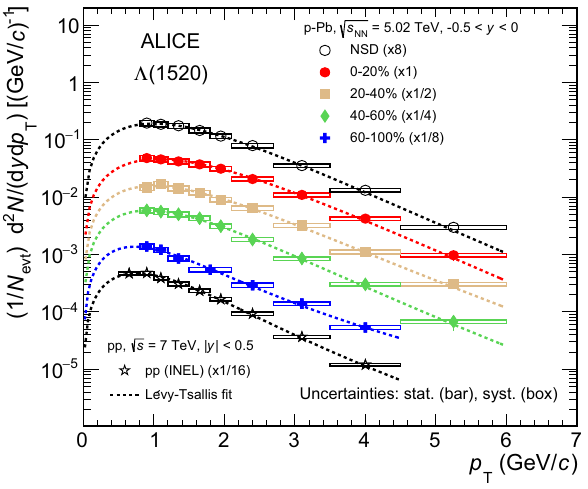
Fig. 3 p T spectra of (cid:3) ∗ measured with ALICE in the rapidity range √ | y | < 0 . 5 in pp collisions at s = 7 TeV and in the rapidity range √ − 0 . 5 < y < 0 in p–Pb collisions at s NN = 5 . 02 TeV for min- imum bias and different multiplicity intervals (V0A estimator). The multiplicity-dependent spectra are normalized to the visible cross- section, whereas the minimum bias spectrum is normalized to the frac- tion of NSD events. The minimum bias spectrum in pp collisions is normalized to the number of inelastic events. Statistical and system- atic uncertainties ( p T -uncorrelated) are indicated as bars and boxes, respectively. Dashed lines represent Lévy–Tsallis fits